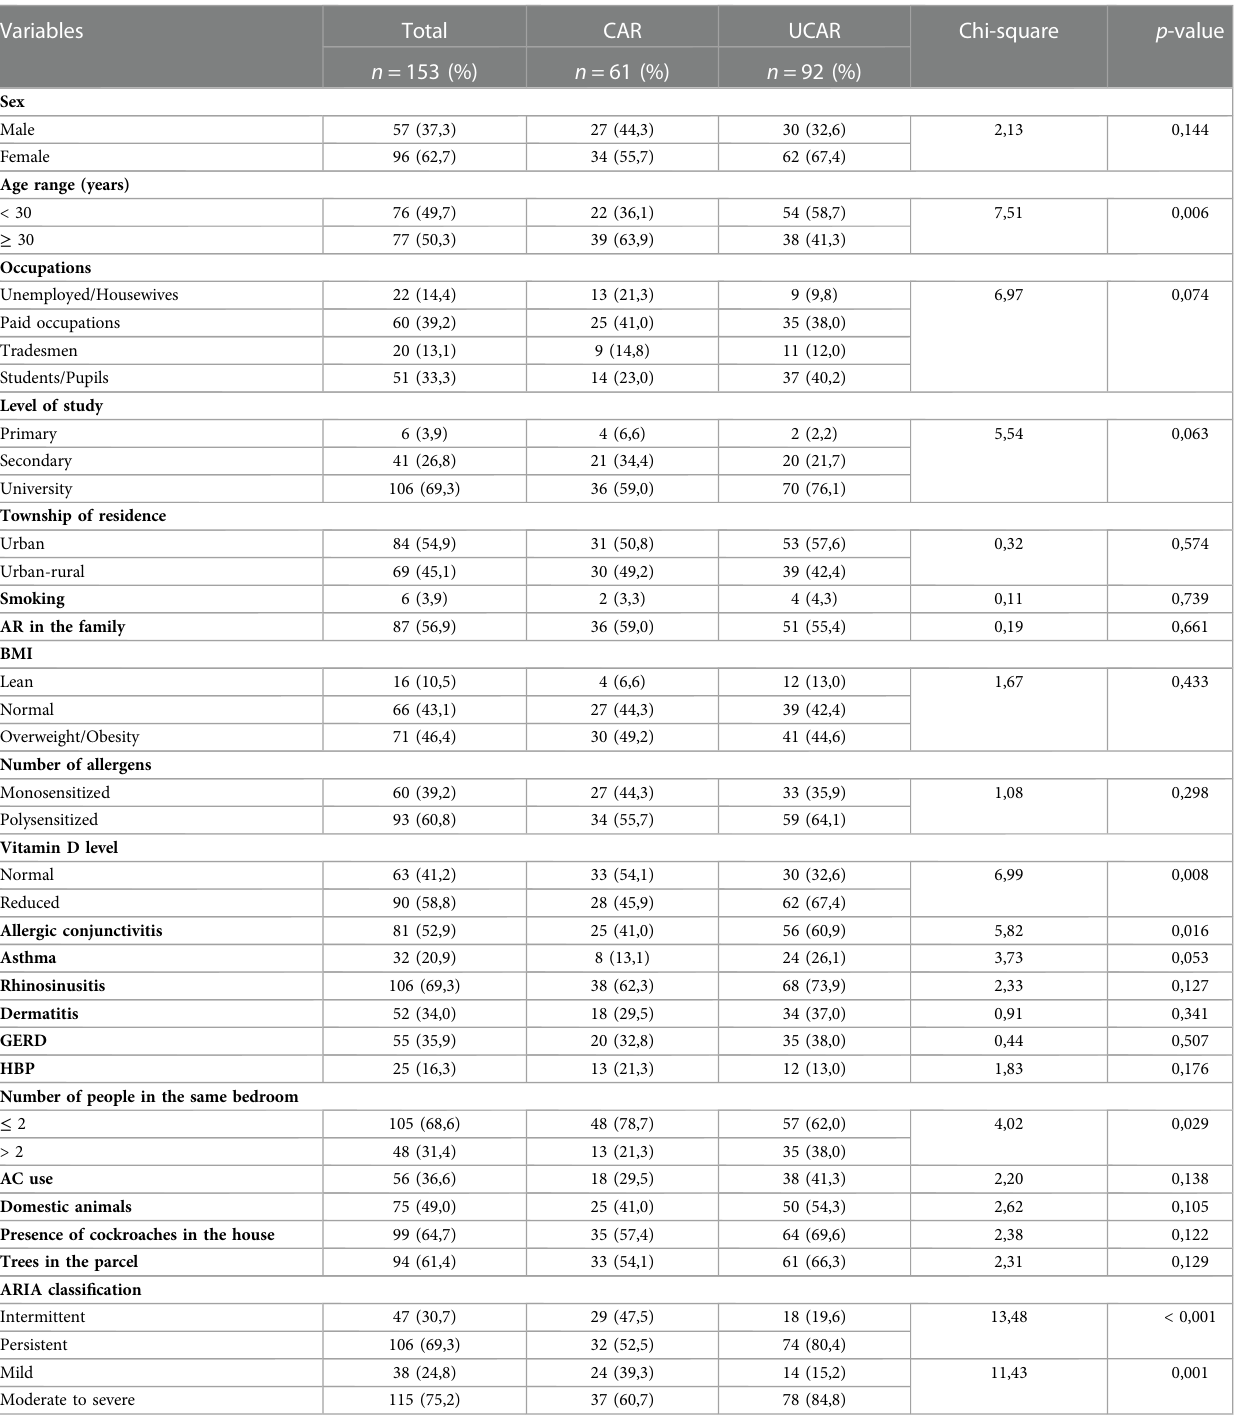
TABLE 1 Sociodemographic and clinical features in patients with controlled and uncontrolled allergic